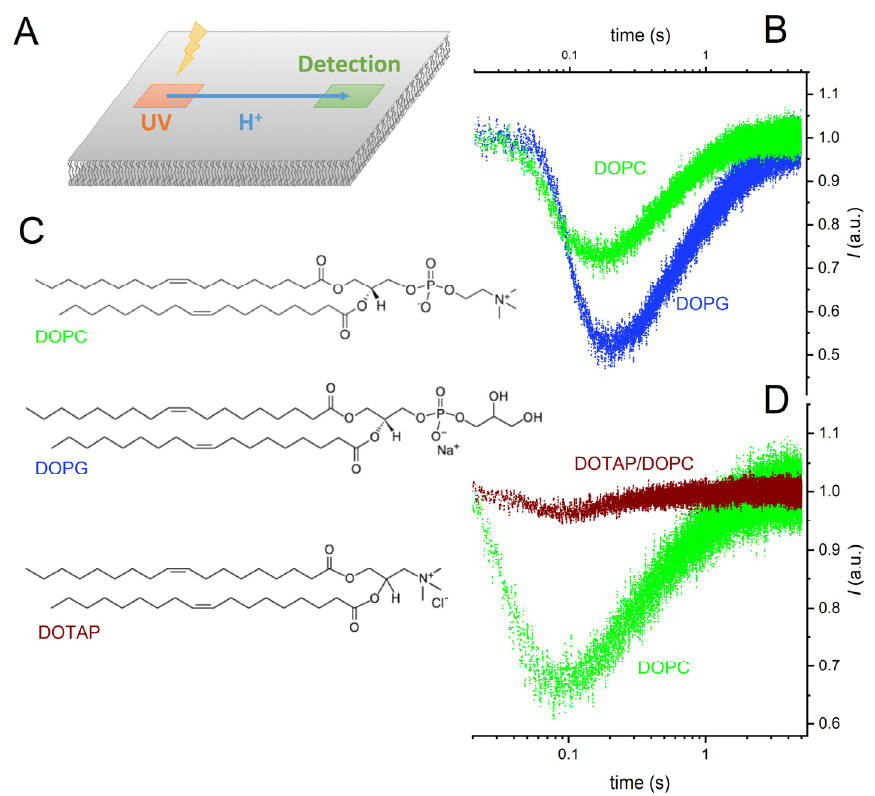
Figure 1. Representative records of interfacial proton migration. ( A ) Experimental scheme. Exposure of a 10 × 10 µm² area to a UV flash released protons from a caged compound that was adsorbed to the surface of a free-standing planar bilayer. The fluorescence of a membrane-anchored pH sensor in a distant 10 × 10 µm²-sized membrane patch changed upon proton arrival. ( B ) The changes in fluorescence intensity measured at a distance of 80 µm with negatively charged bilayers (1,2-di- oleoyl-sn-glycero-3-phospho-(1’-rac-glycerol), DOPG) and uncharged bilayers (1,2-dioleoyl-sn- glycero-3-phosphocholine, DOPC) differ from each other. ( C ) Structural formulas of the three lipids: DOPC, DOPG, and 1,2-dioleoyl-3-trimethylammonium-propane (DOTAP). ( D ) The changes in flu- orescence intensity at a distance of 50 µm are smaller for positively (DOTAP/DOPC mixture) charged membranes than for DOPC membranes. The four colored traces are data from representative individual release events. The buffer (pH = 9) contained 10 mM KCl.